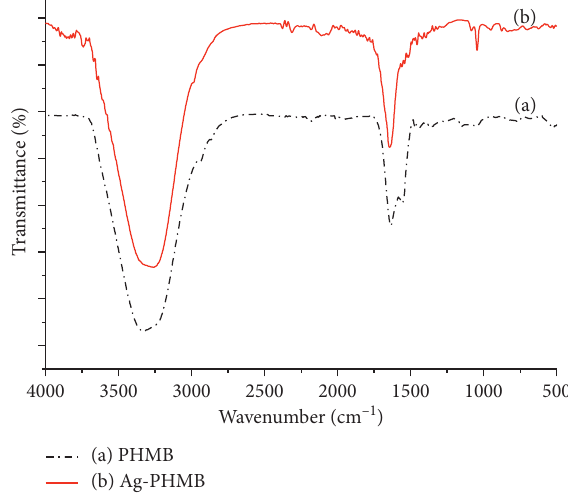
Figure 6: FTIR spectra (a) PHMB and (b) AgNPs stabilized by PHMB